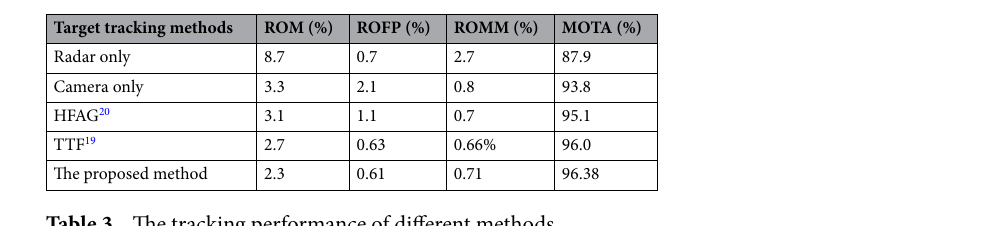
Table 3. The tracking performance of different